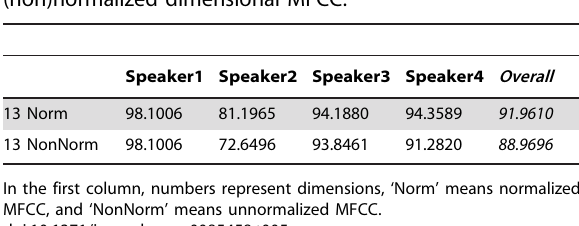
Table 5. Accuracy (%) by using original DTW on different (non)normalized dimensional